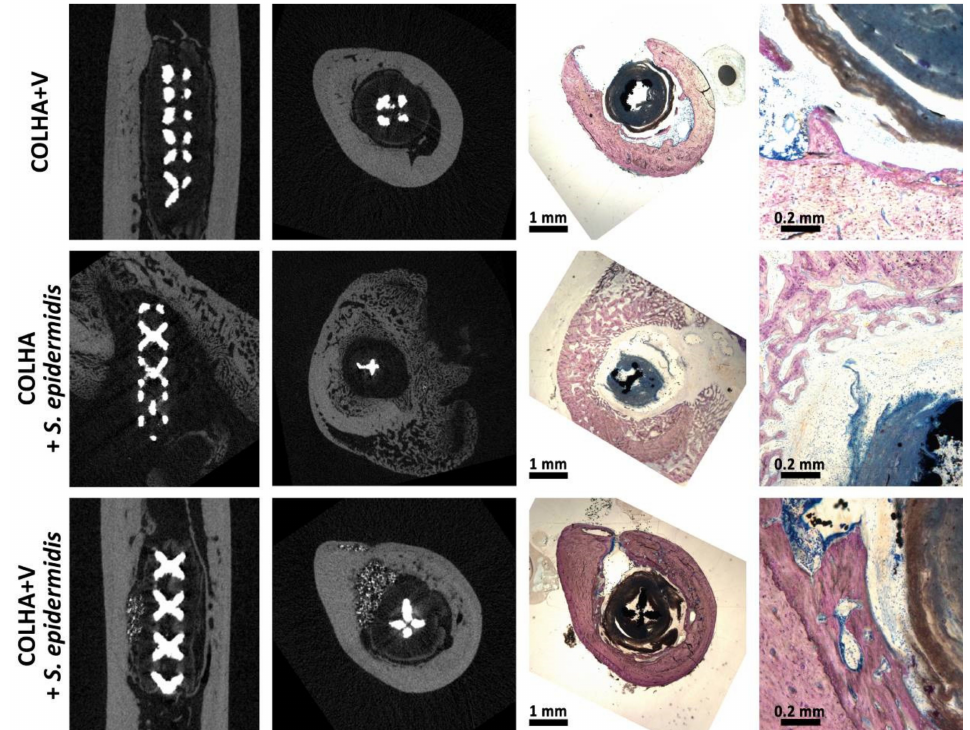
Figure 4. Representative micro-CT and histological images of identical samples in the COLHA+V implants without the application of S. epidermidis (upper line), COLHA implants with S. epidermidis (middle line), and COLHA+V with S. epidermidis (bottom line) groups.